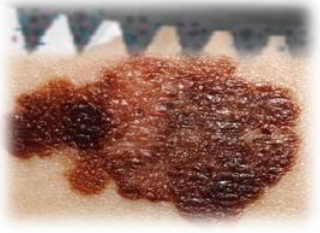
Figure 7. Microneedles toward melanoma.